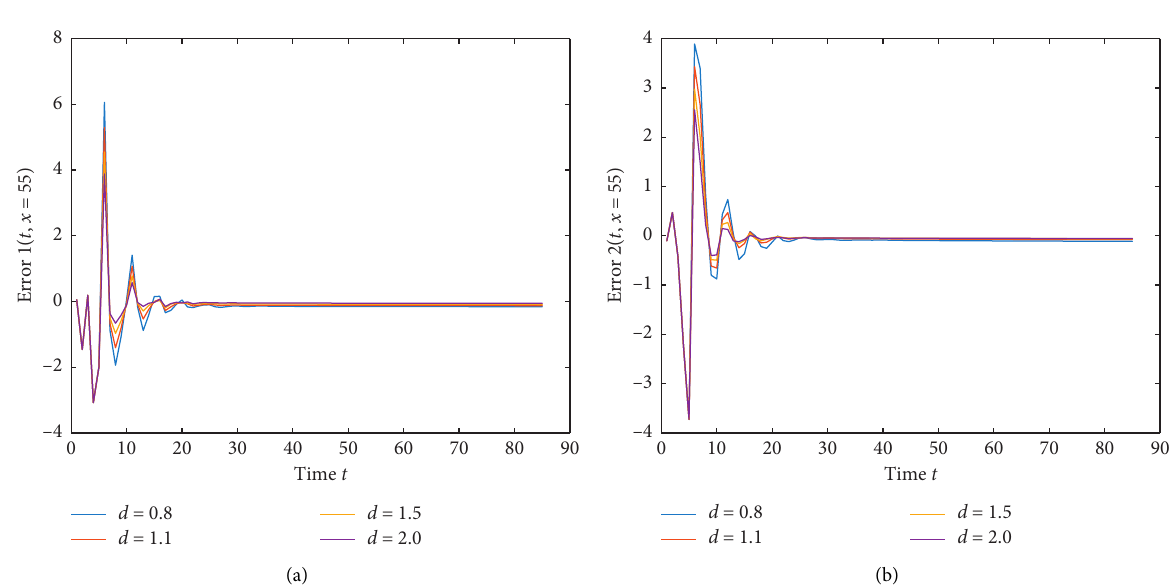
Figure 8: Trajectories of error system (26) at spatial position x � 55 under different diffusion